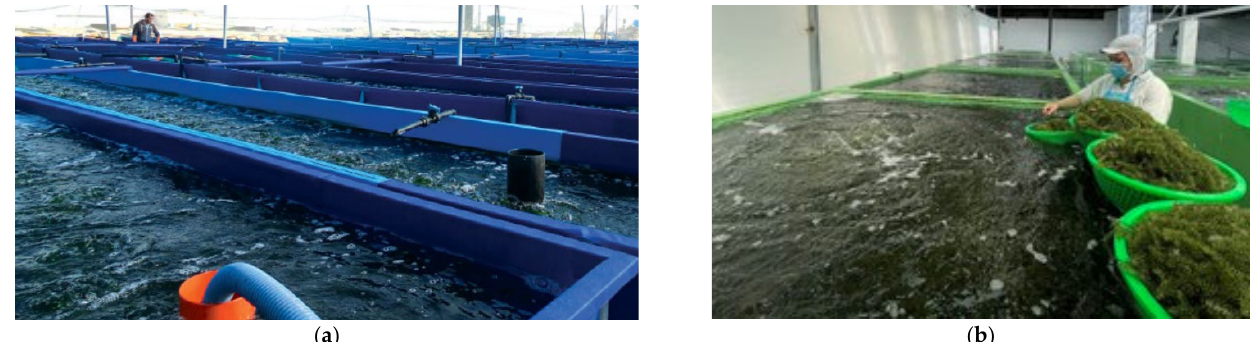
Figure 4. ( a ) Farming Ulva and Gracilaria in Israel (https://seakura.co.il/en/ (accessed on 22 Septem-